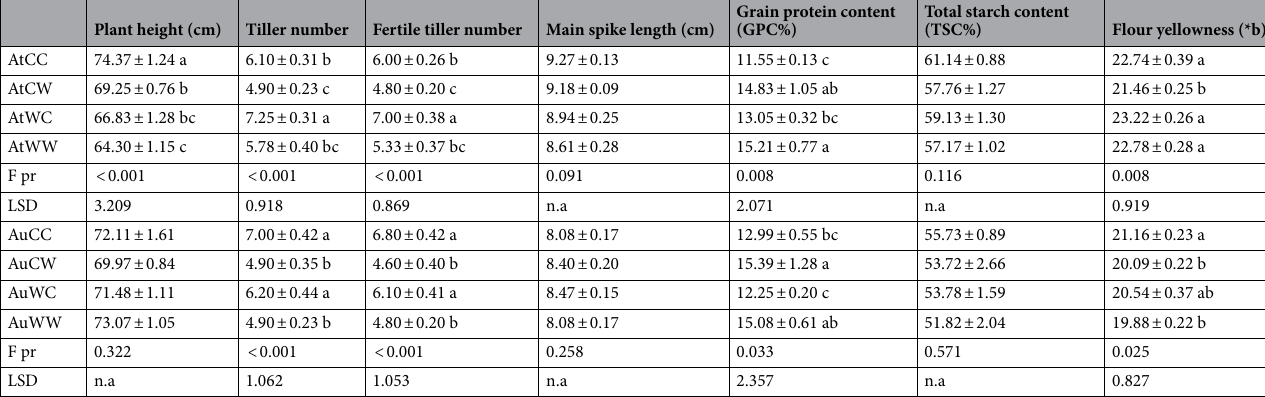
Table 2. Effect of transgenerational water stress on morphological traits and grain quality traits measured at harvest for two durum wheat genotypes. Means ± SE for n = 10 are shown for morphological traits. Means ± SE for n = 4 are shown for grain quality traits. Different letters (a, b, c) denote statistically significant differences among treatment groups within each genotype, using least significant difference (LSD) when P < 0.05. The treatment groups are: AtCC (DBA Artemis control group parents, progeny treated with control), AtCW (DBA Artemis control group parents, progeny treated with water-deficit stress), AtWC (DBA Artemis water-deficit stress group parents, progeny treated with control), AtWW (DBA Artemis water-deficit stress group parents, progeny treated with water-deficit stress); AuCC (DBA Aurora control group parents, progeny treated with control), AuCW (DBA Aurora control group parents, progeny treated with water-deficit stress), AuWC (DBA Aurora water-deficit stress group parents, progeny treated with control), AuWW (DBA Aurora water-deficit stress group parents, progeny treated with water-deficit